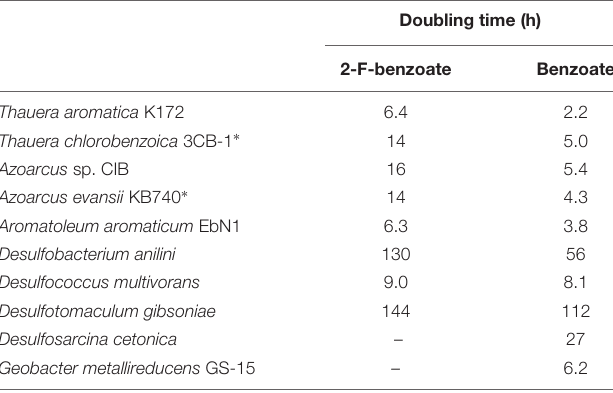
TABLE 1 | Anaerobic growth of selected bacterial strains with 2-F-benzoate.